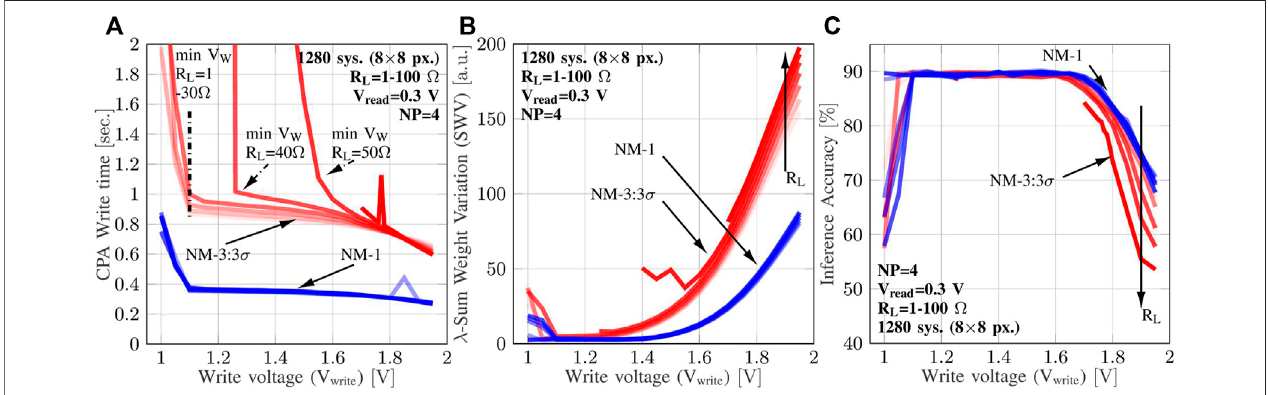
FIGURE 7 | Simulation results for the synaptic weights writing process into the partitioned CPA-based SLP. (A) Total Write Time, (B) λ -SWV and (C) Inference accuracy obtained with the written SLP as a function of the write pulses amplitude. In all cases, the two normalization methods were considered ( NM-1 and NM-2 ) and the line resistance was varied in the range from 1 to 100 Ω